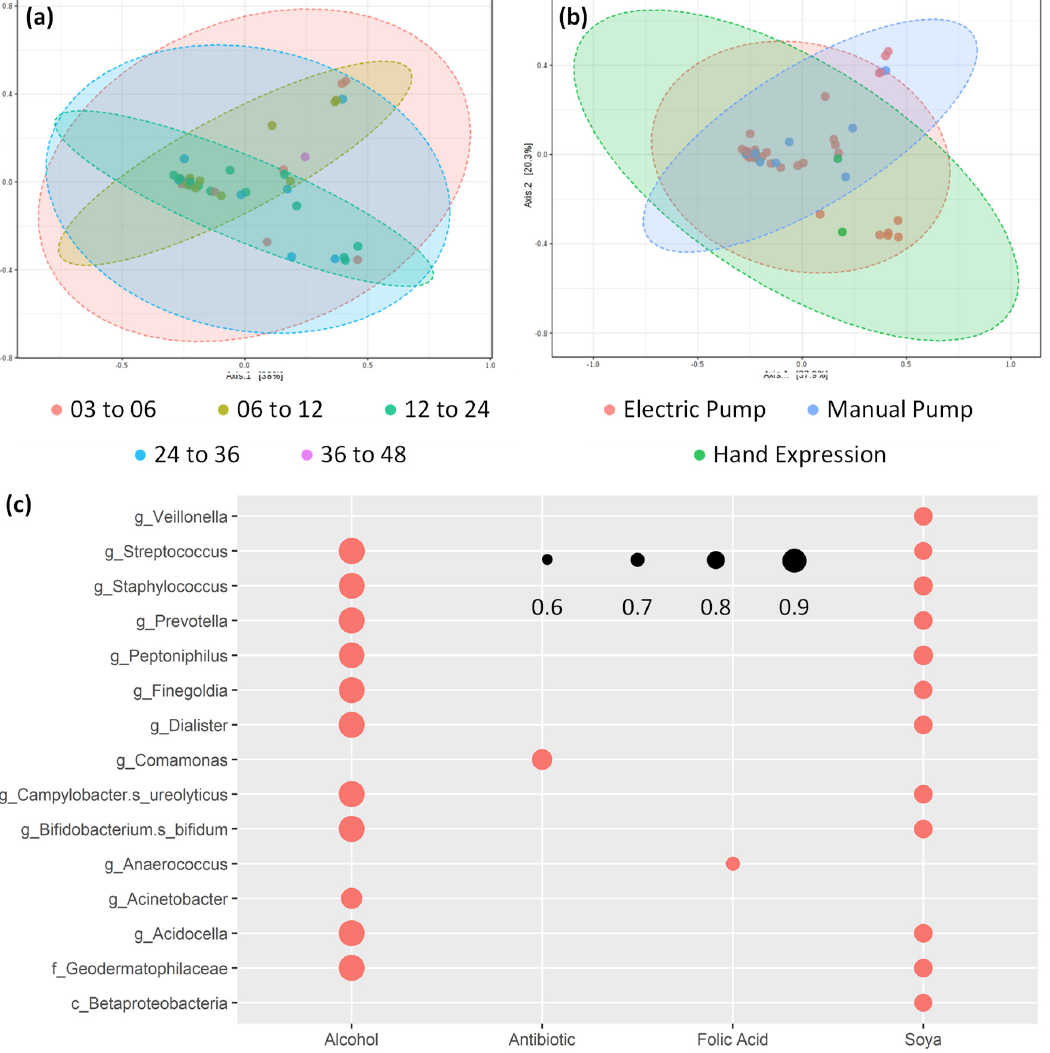
Figure 2. Microbiome fingerprinting shows influence of lifestyle factors but not nursling age. Metataxonomics using amplicon sequencing of the 16S rRNA gene shows no significant separation (PERMANOVA p value above 0.05) in beta diversity for ( a ) age of nursling nor ( b ) expression method using principal coordinate analysis. Shading shows 95% confidence intervals of groupings. Additionally, ( c ) lifestyle factors were correlated with microbiome features at the finest taxonomic resolution achieved. Size of dot indicates size of correlation and only positive correlations were significant, with p value below 0.05. A total of 46 human milk replicates were used in this